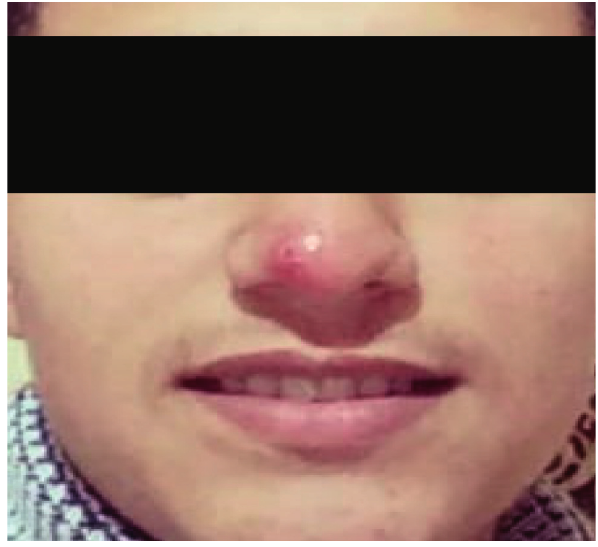
Figure 1: Onset lesion of the nasal infection.